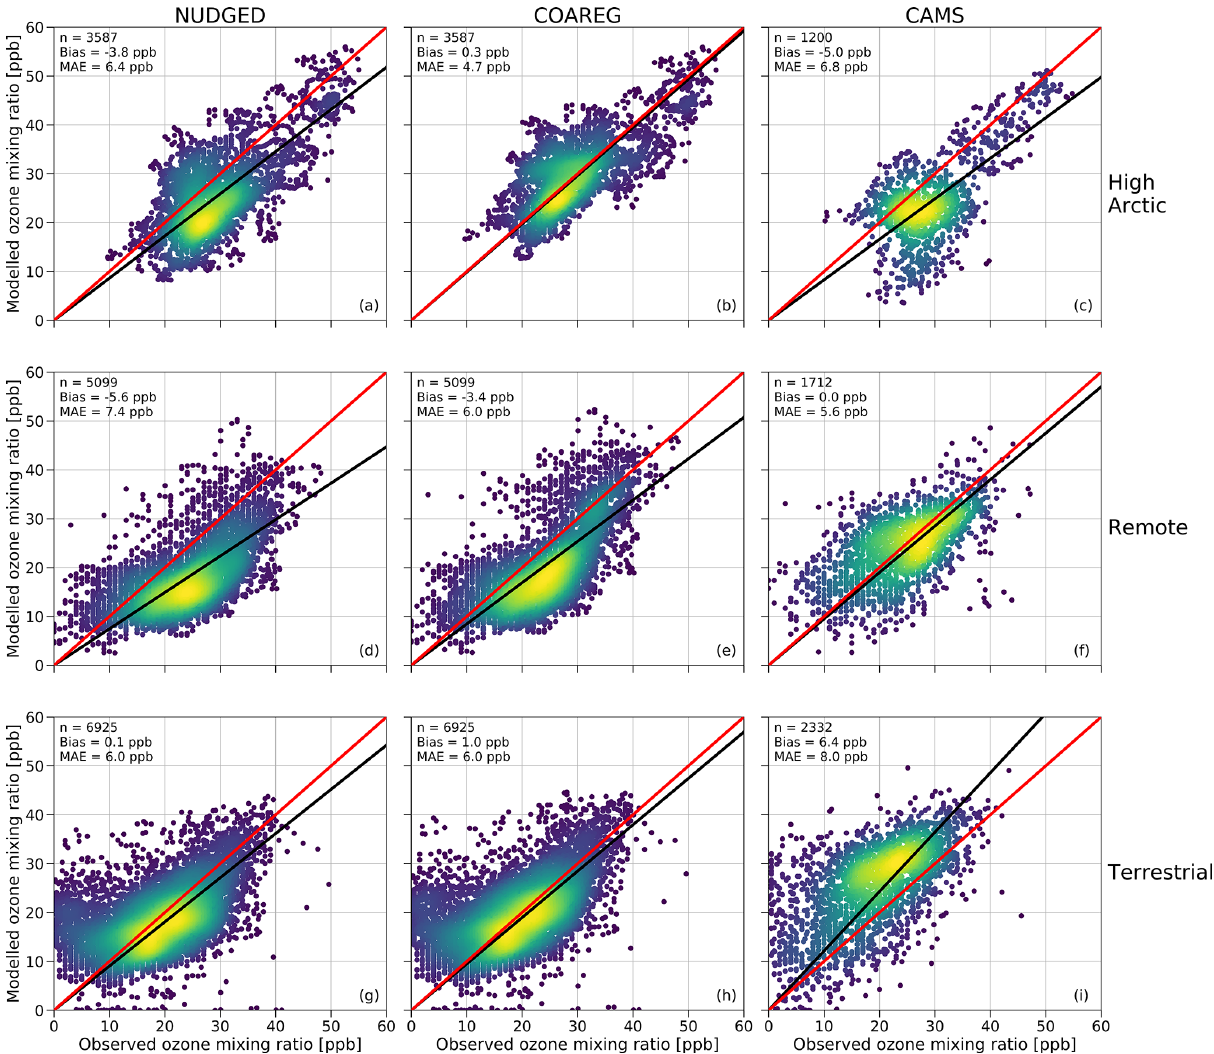
Figure 4. Comparison of the hourly observed and simulated ozone mixing ratios (ppb) for the NUDGED (a, d, g) and COAREG (b, e, h) runs and CAMS data (c, f, i) for the High Arctic (a–c) , Remote (d–f) and Terrestrial (TE) (g–i) sites. The red line indicates the 1:1 line and the black line indicates the ordinary least squares regression line through the origin. The number of data points ( n ), bias (ppb) and mean absolute error (MAE) (ppb) are shown in the top left corner. The colors represent the multivariate kernel density estimation with yellow colors having a higher density.